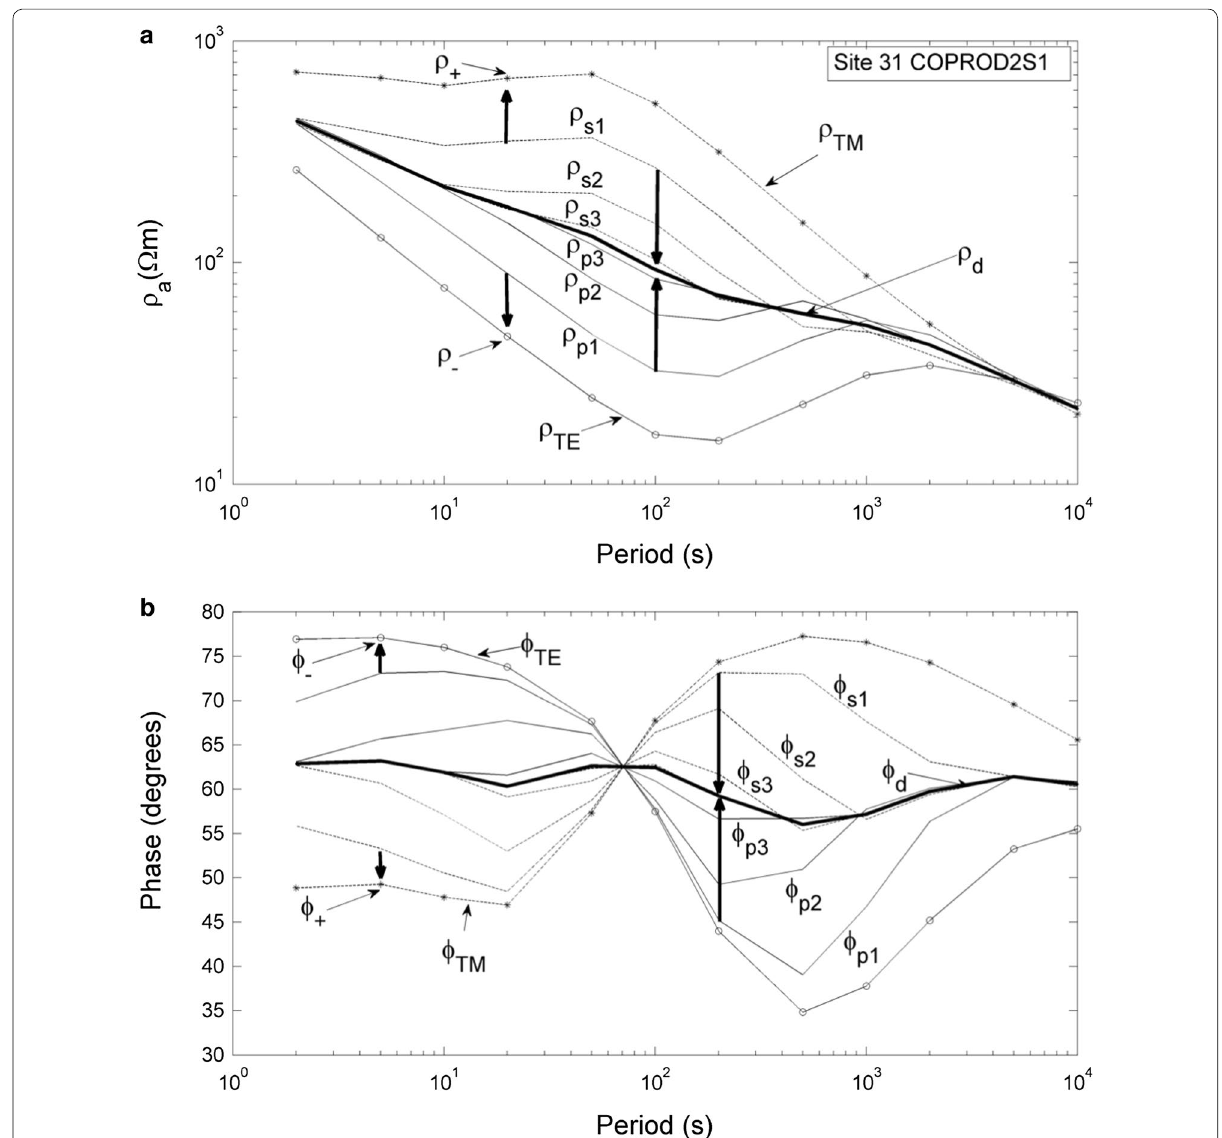
Fig. 1 Graphical illustration of the infinite chain of invariants and of the missing first link: a apparent resistivity curves; b phase curves. The longer arrows indicate the direction toward convergence of the infinite chain. The shorter arrows indicate the direction toward the missing first links given by the solution of the quadratic equation. The TE and TM resistivities coincide with ρ